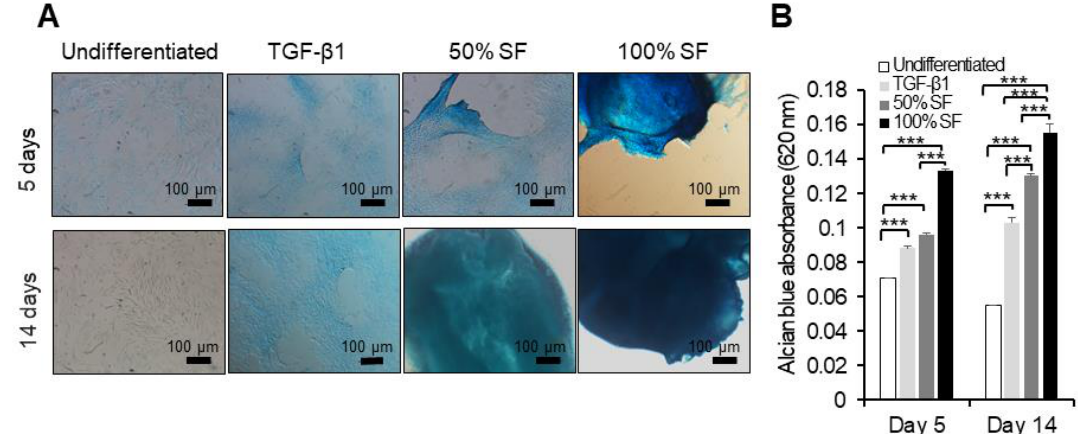
Figure 4. Evaluation of chondrogenic differentiation in the presence of autologous synovial fluid. BMMSCs were cultivated as monolayer in the presence of 50% and 100% of autologous synovial fluid or chondrogenic differentiation medium containing TGF-β1 for up to 14 days. The MSCs were stained using Alcian blue. ( A ) Photomicrographs of MSCs at days 5 and 14 show cartilage glycosaminoglycans (blue) indicative of chondrogenic differentiation. ( B ) Total glycosaminoglycan (GAG) production in the monolayer at different time points. *** p < 0.001. Quantitative data are expressed as mean ± SD ( n = 3) and were analyzed using one-way ANOVA, with Tukey’s comparison test as a posttest. p < 0.05 was considered statistically significant. One representative experiment is presented from three different experiments using cells from different donors ( n = 3), each performed in triplicate.